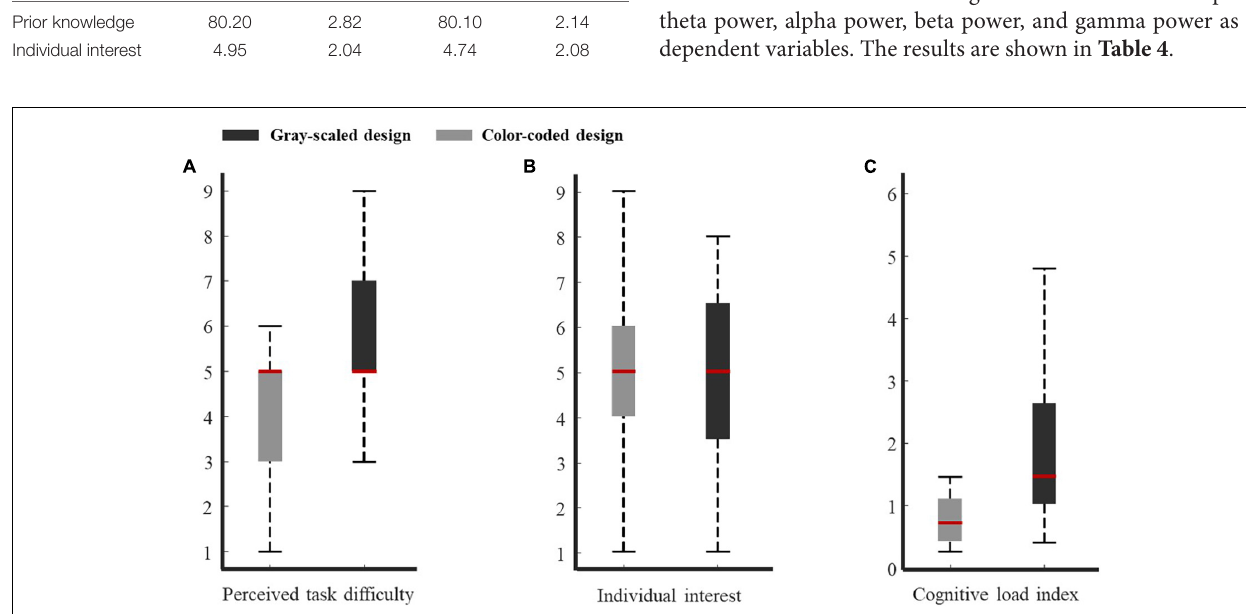
FIGURE 3 | Boxplot data for participants in two conditions. (A) Perceived task difficulty. (B) Individual interest. (C) Cognitive load.